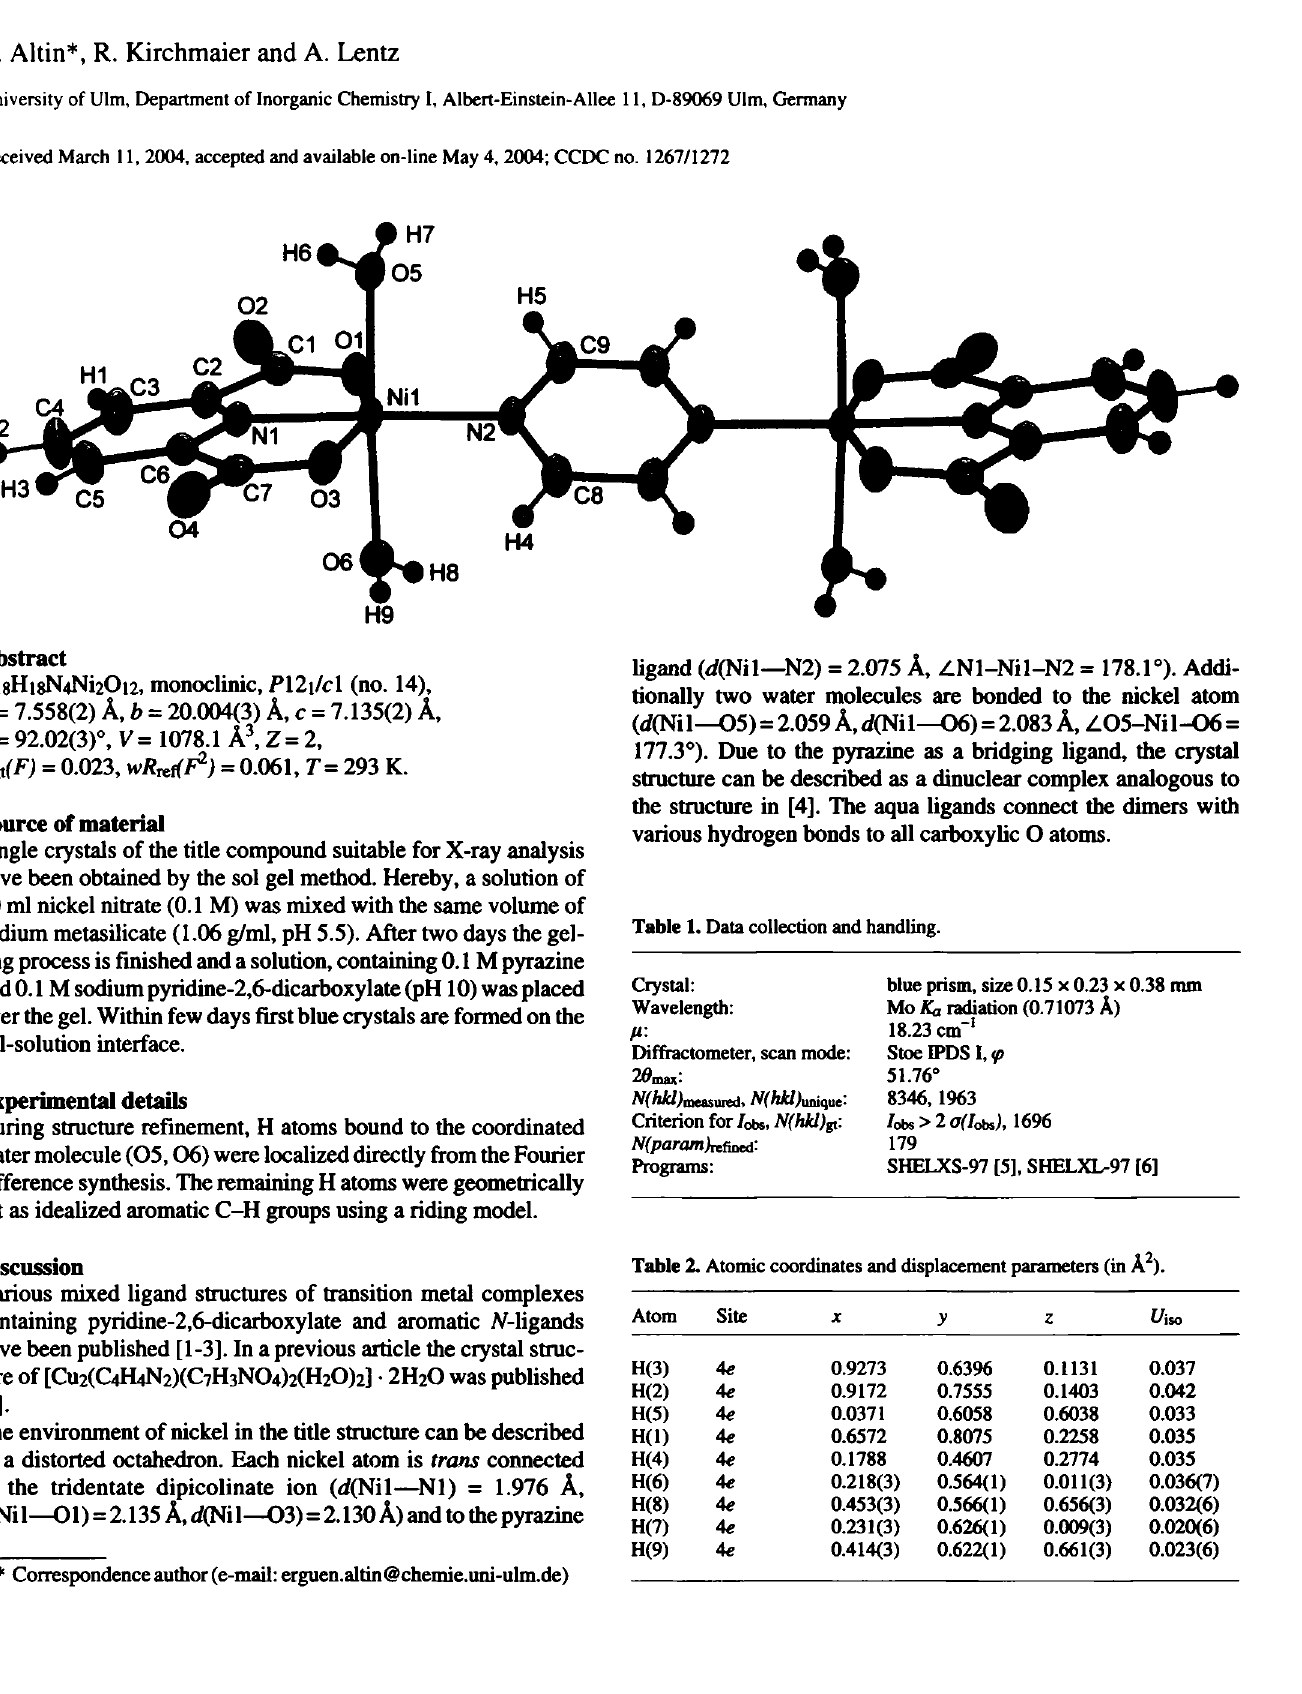
Table I. Data collection and handling.